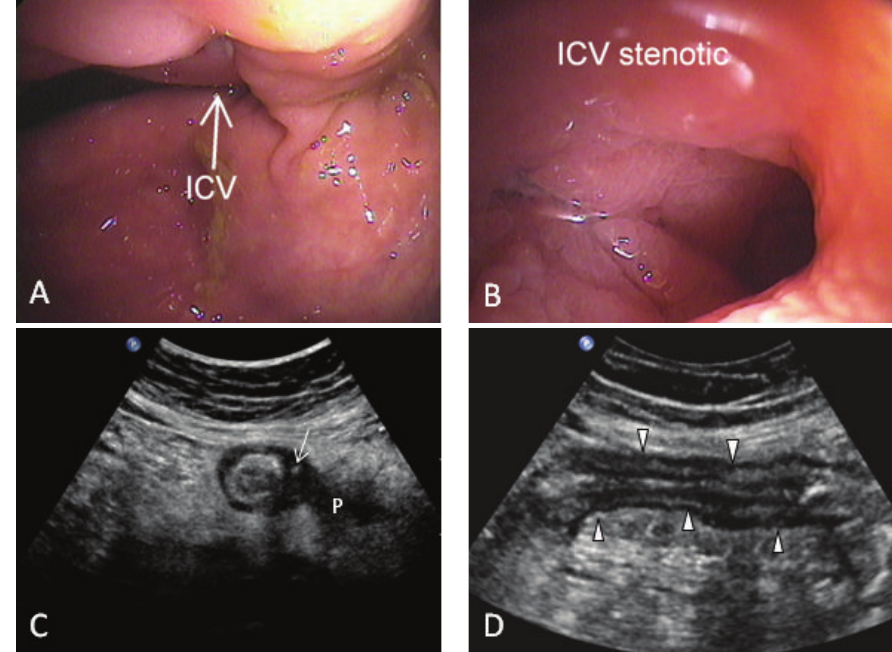
Figure 4: Complicated Crohn’s disease on ultrasound only. 45-year-old female with a 2-year history of Crohn’s disease. Colonoscopy failed to intubate the terminal ileum and did not detect any active disease. (A) shows the ileocecal valve (ICV) and (B) shows a close-up view of the orifice with limited view of the terminal ileum (TI). (C) An axial ultrasound image of the TI shows mural thickening and surrounding inflammatory fat. The wall is eccentrically thickened and shows intramural extraluminal air (arrow), suggestive of localised perforation. A poorly marginated hypoechoic zone within the inflammatory fat suggests a phlegmon (P). (D) is the corresponding sagittal image of the thickened TI. Interpretation: acute local perforation and phlegmon. After ultrasound, the patient was referred to